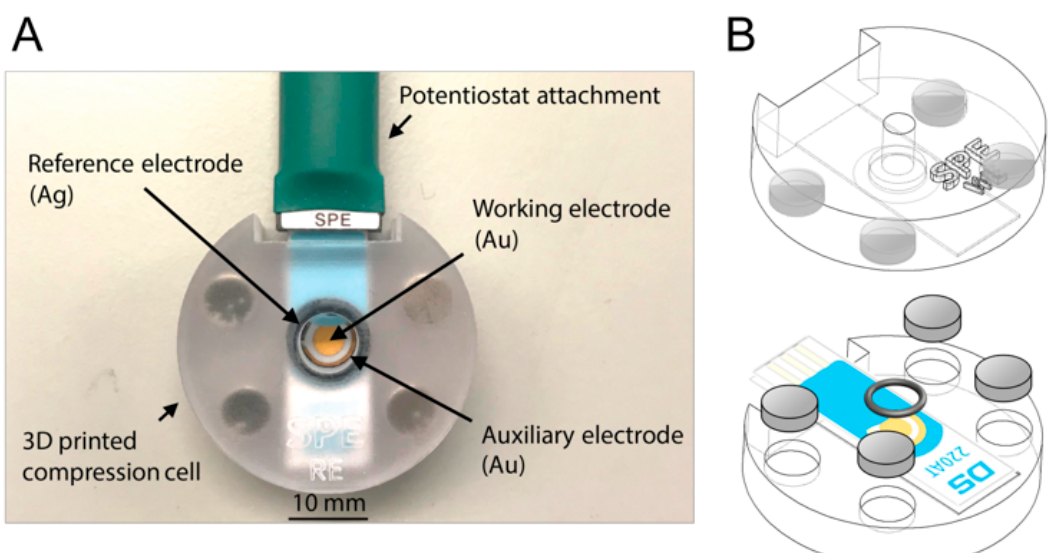
Figure 2. Image of the 3D-printed static flow cell with mounted screen-printed electrode (SPE) and connected cable ( A ) and illustration of the setup (here with top part enclosing only the working electrode of SPE) ( B ).